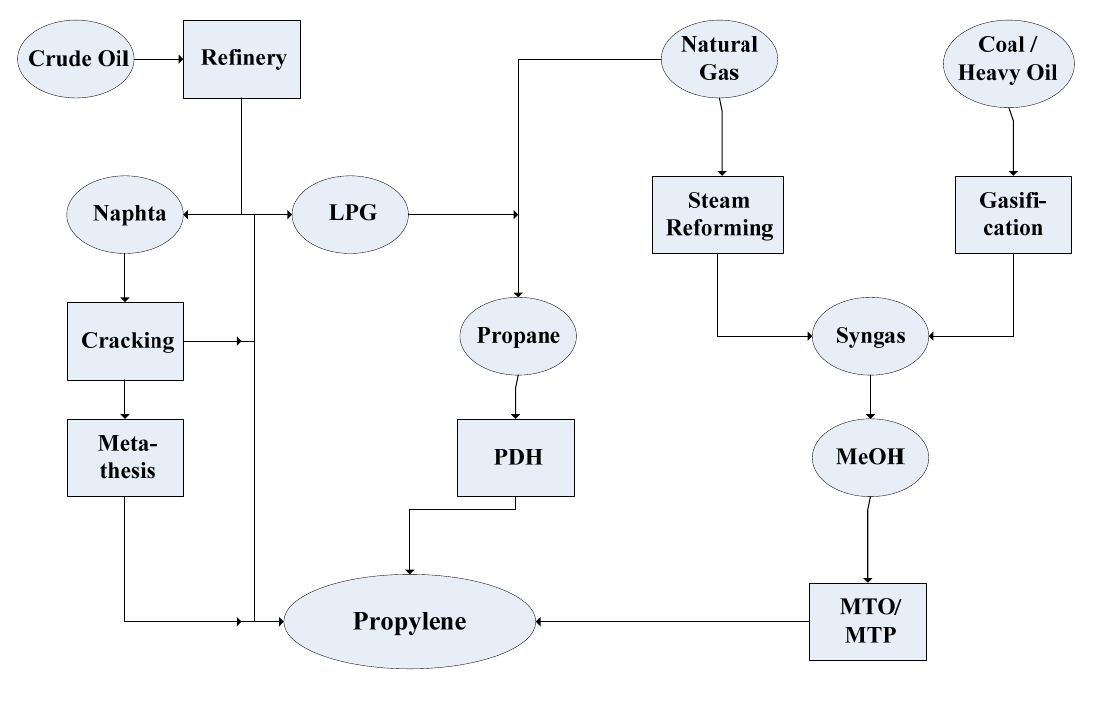
Figure 1. Propylene value